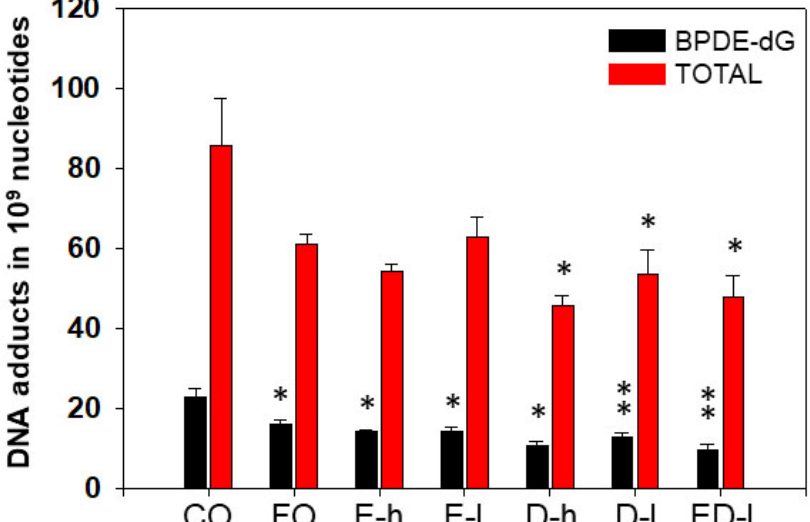
Figure 5. FO, EPA, and DHA significantly decreased liver BPDE-dG and total levels of DNA adducts in A/J mice compared to CO. DHA also significantly decreased hepatic total DNA adducts compared to CO. *, p < 0.05; **, p < 0.01 ( n = 4–5, one-way ANOVA). E, EPA; D, DHA, h, high dose; l, low dose.